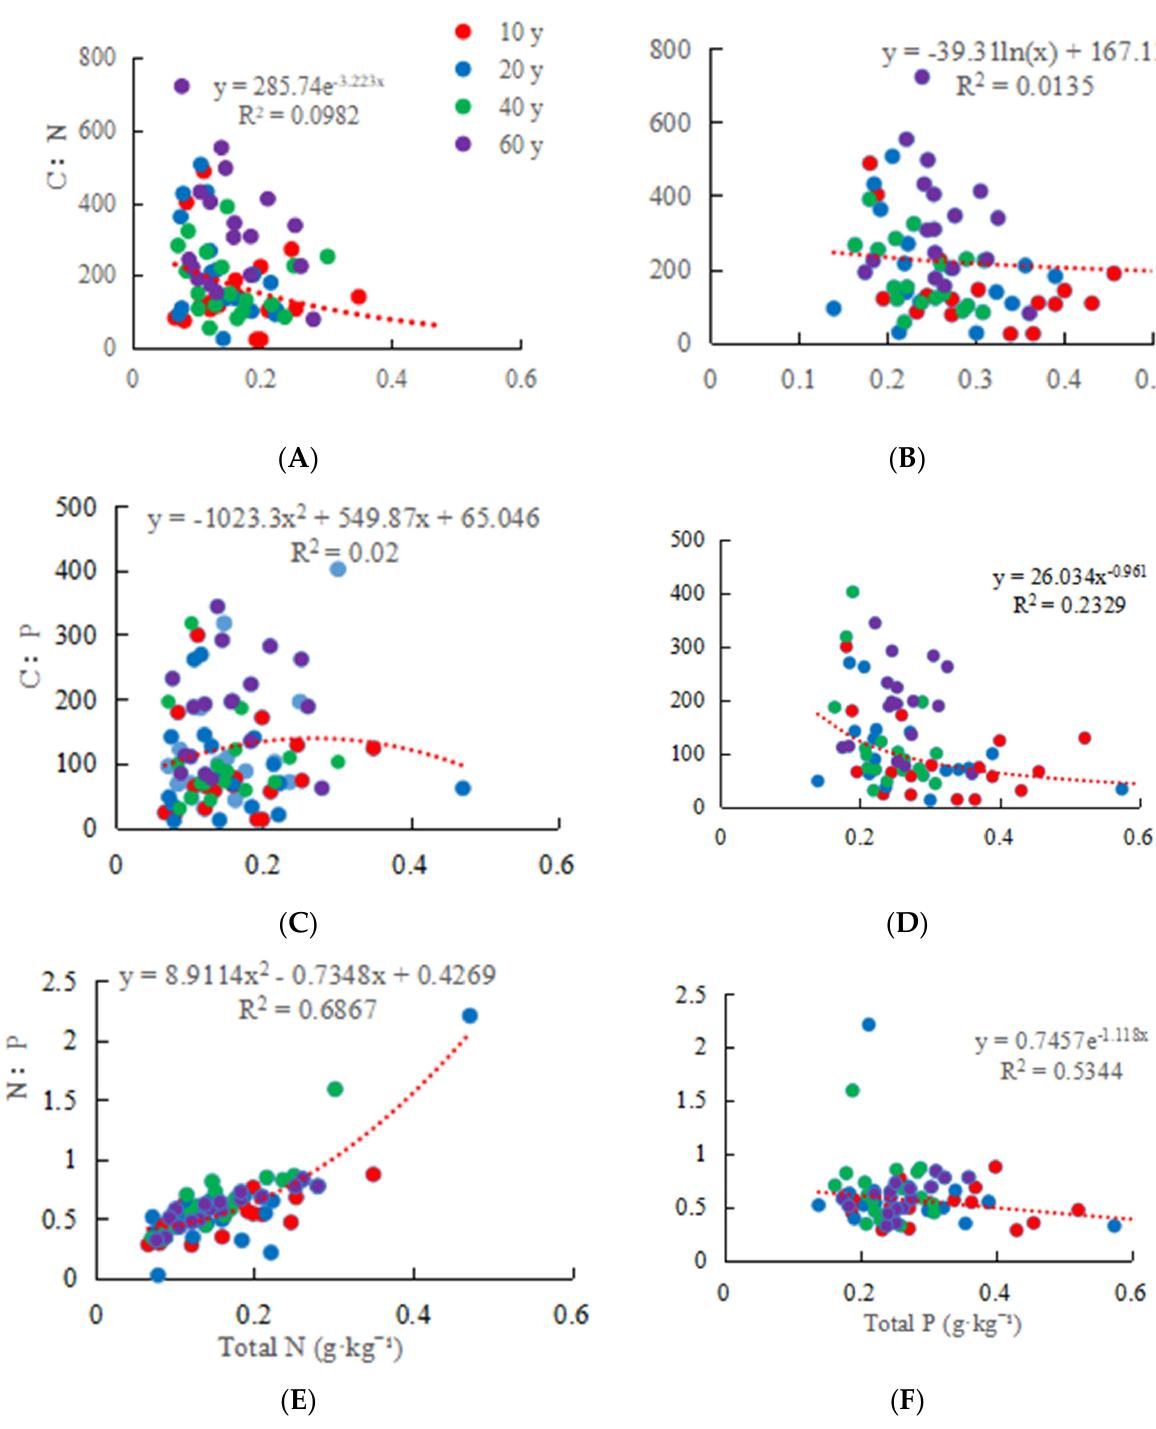
Figure 4. Relationships between soil chemometrics in different-aged forests. The graphs represent ( A – F ) the ordinate of two identical; ( A , C , E ) between the same abscissa; and ( B , D , F ) between the abscissa of the same. C:N, C:P, and N:P represent the ratios of soil total organic carbon to total nitrogen, total organic carbon to total phosphorus, and total nitrogen to total phosphorus, respectively.